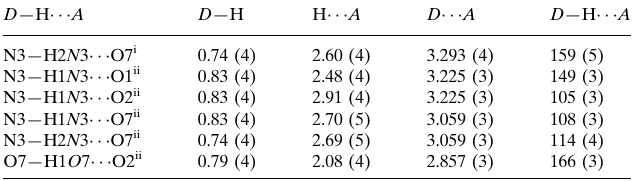
Hydrogen-bond geometry (A˚ , (cid:2)